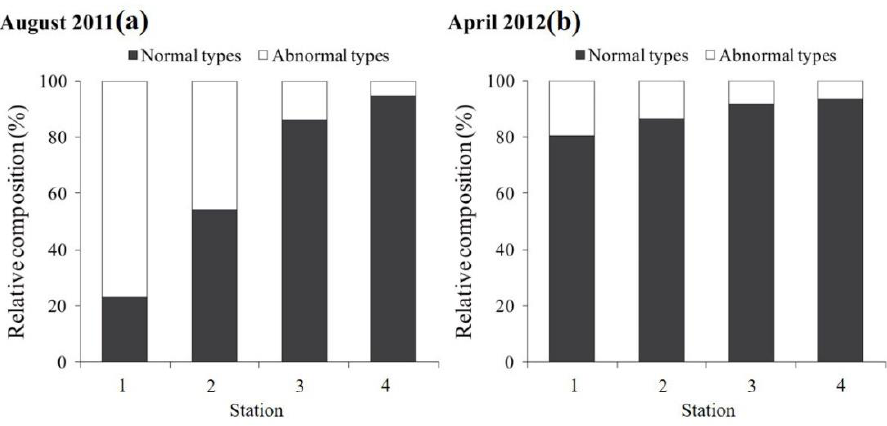
Figure 6. Relative composition of normal and abnormal eggs in the sediment of Masan Bay. ( a ) August 2011, and ( b ) April 2012.